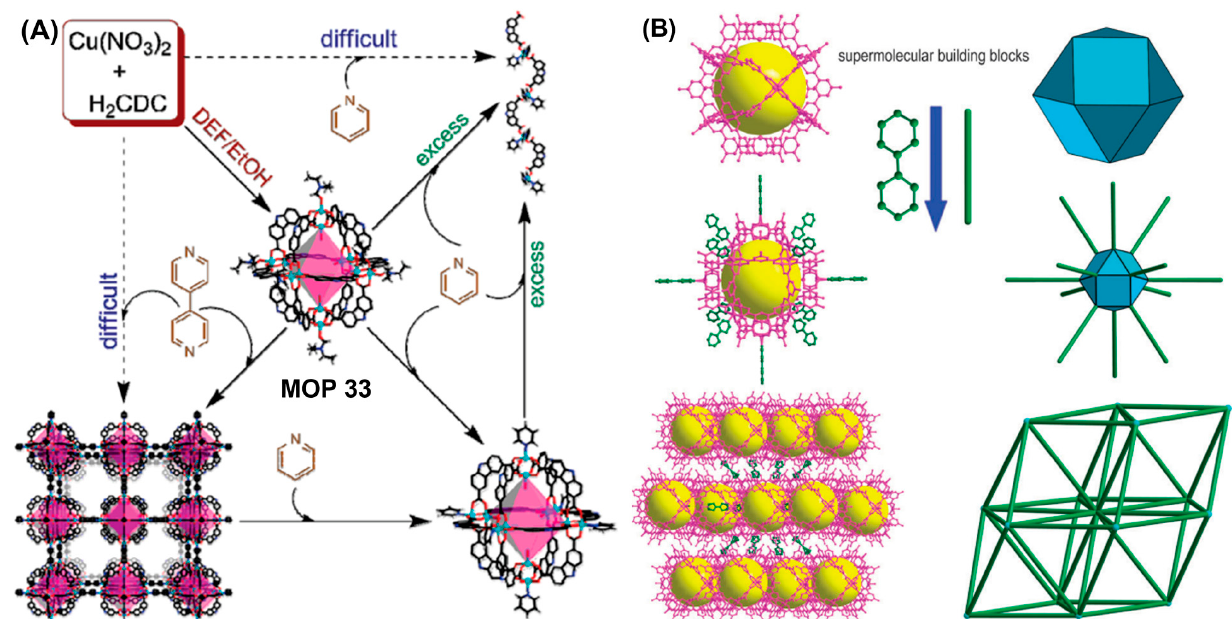
Figure 17. ( A ) Reaction scheme for the modification MOP 33 into pyridine-coordinated MOP, bypyridine-directed MOF, and a continuous 1D chain. ( B ) Extended structures based on NH 2 -MOP as a precursor. Schematic diagram showing the appropriate strategy for obtaining MOFs from MOPs. Reprinted by permission from Refs. [92,153]. Copyright 2009 from American Chemical Society and copyright 2011 from Royal Society of Chemistry.